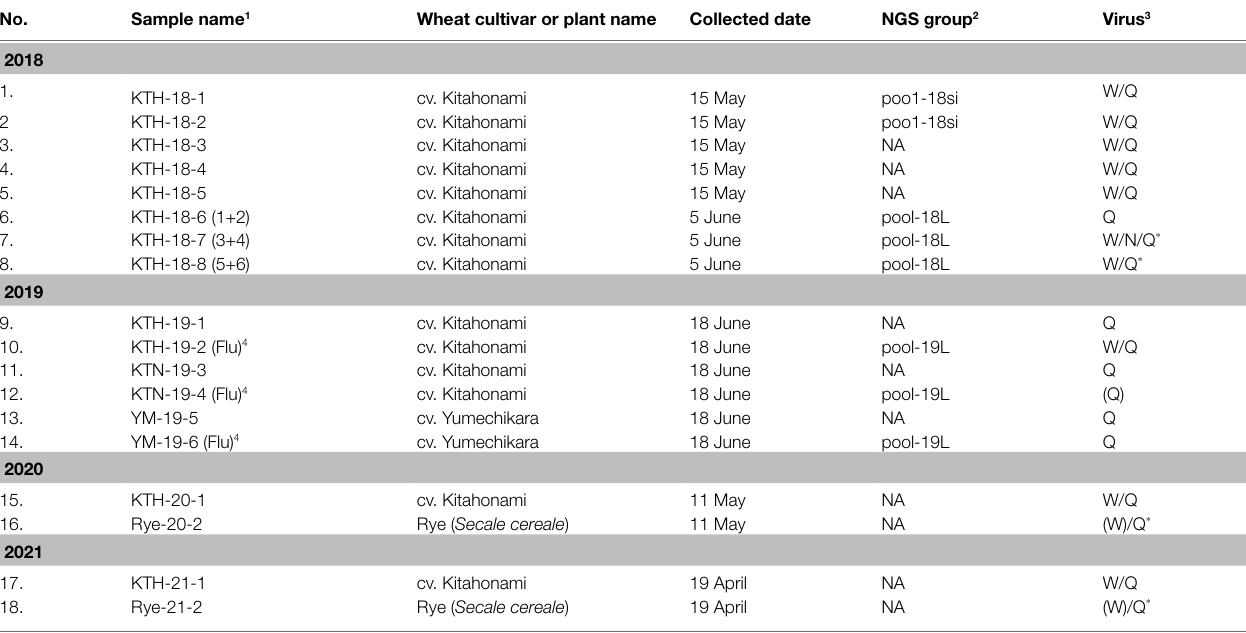
TABLE 1 | List of field-collected samples used in this study and the viruses identified by RNA-seq.